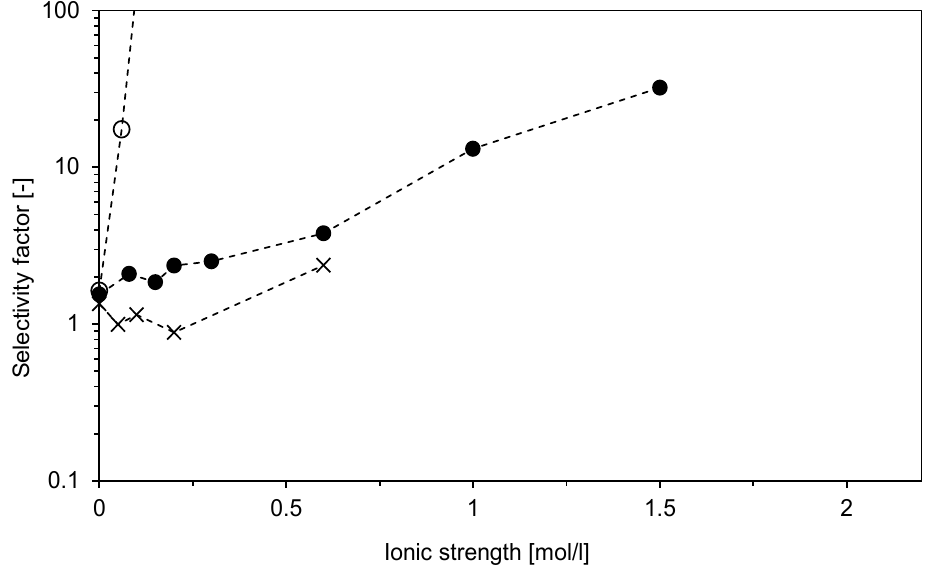
Figure 11. Influence of salt type and ionic strength on two-component adsorption of BSA and DNA on Sartobind STIC using a micromembrane module with pump-forced flow at a pH of 8. The selectivity factor represents the ratio of distribution factors plotted in Figure 7. NaCl ( ● ), NH 4 Cl ( 🞨), and Na 2 SO 4 ( ○) . Connecting lines are included only for better visualization of trends.